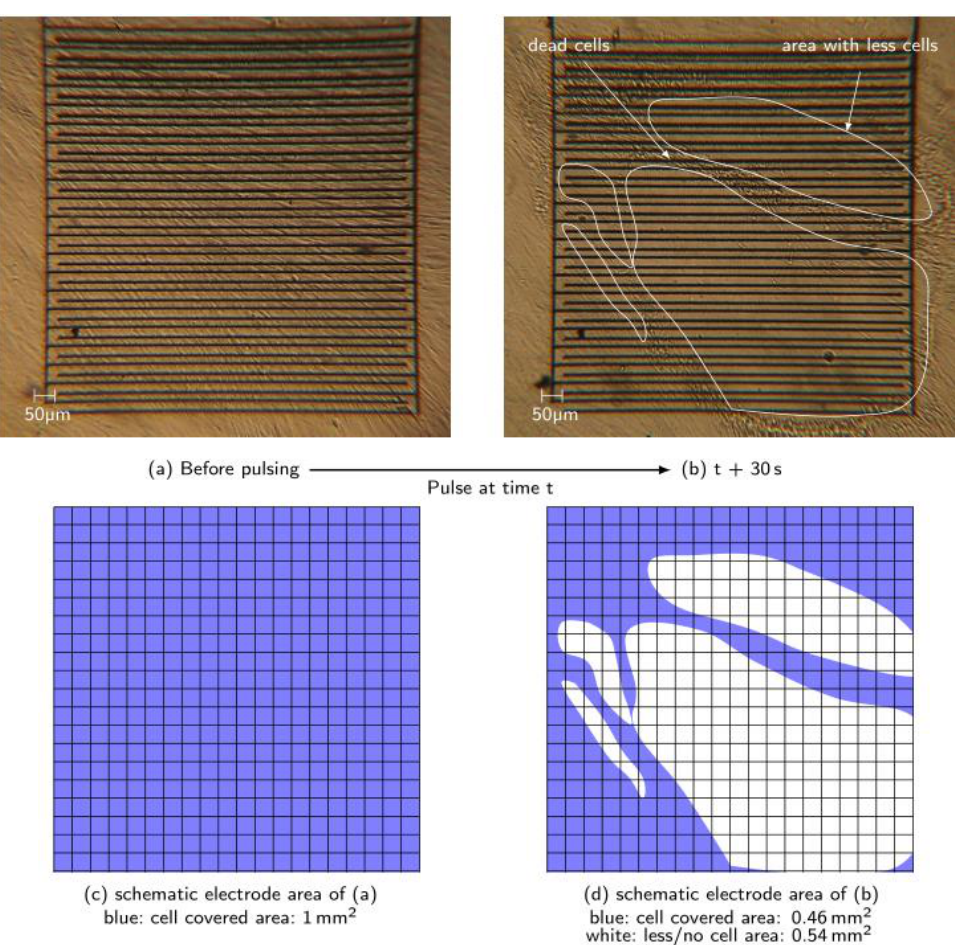
Figure 7. ( a ) Picture of the electrode with 100% cell confluence before nsPEF treatment; ( b ) picture of the electrode 30 s after applying the pulses. Cells were still partially adhered and partially already detached, which results in areas with significantly less cells. Vital cells were still observed at the edges of